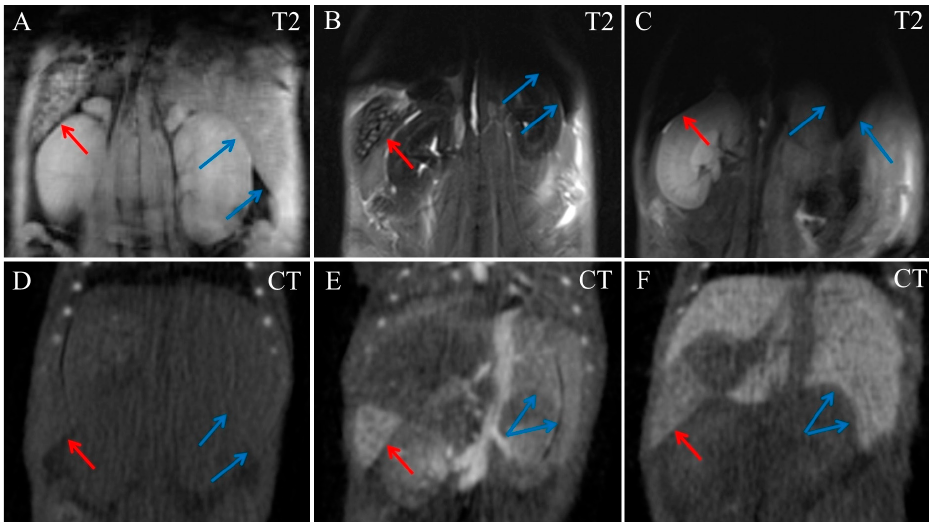
Figure 3. Coronal MRI and CT images of the mouse abdominal area. ( A ) Native T2 MRI; ( B ) T2 MRI, 5 min post injection of Fe 3 O 4 @Au; ( C ) T2 MRI, 17 days post injection of Fe 3 O 4 @Au; ( D ) Native CT image; ( E ) CT image, 22 min post injection of Fe 3 O 4 @Au; ( F ) CT image, 17 days post injection of Fe 3 O 4 @Au. Red arrows indicate the spleen, blue arrows indicate margin of the liver.